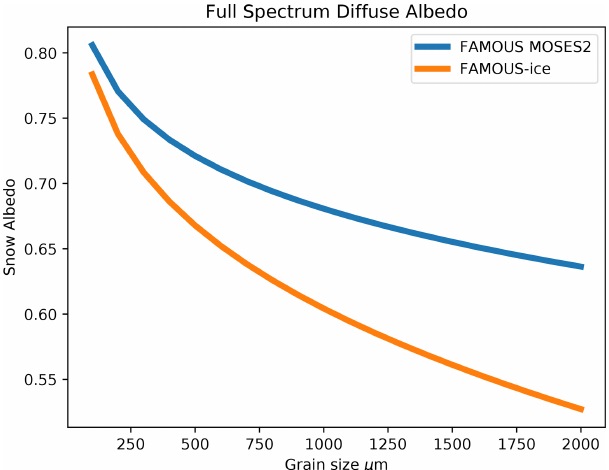
Figure 3. Variation of broadband albedo with surface snow grain size for FAMOUS-ice (orange) and the previous version of FA- MOUS (xfhcu,